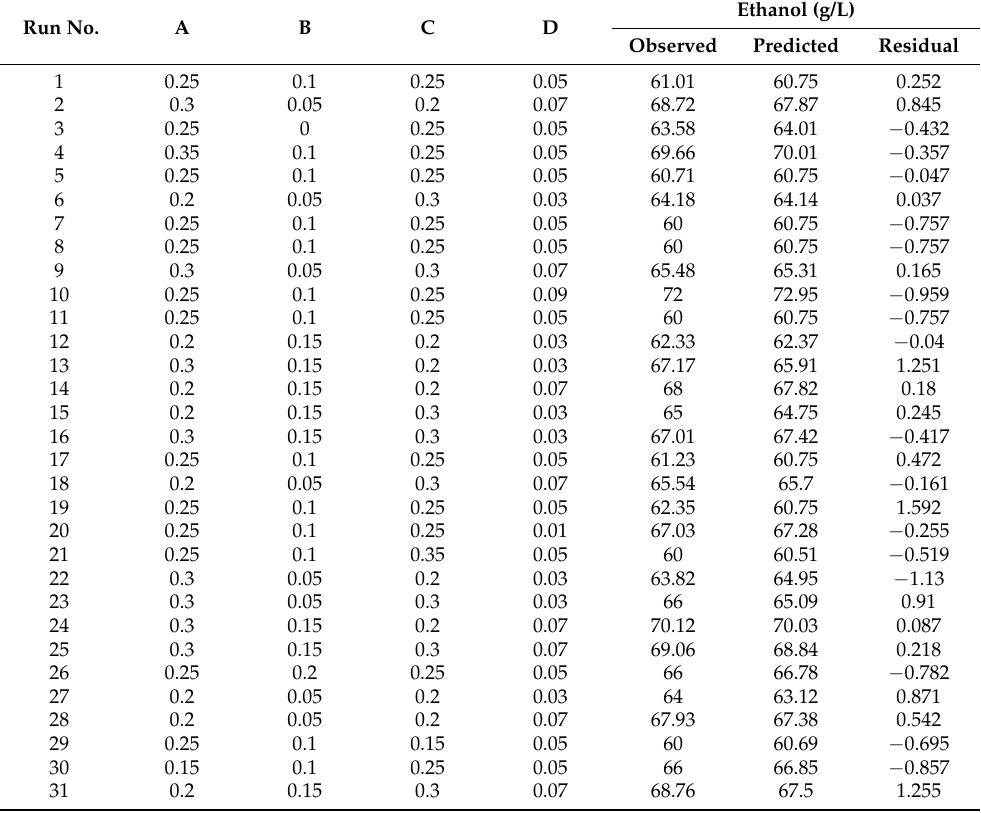
Table 2. CCD for optimizing nutritional parameters (g/L) for production of ethanol in SSF. Run